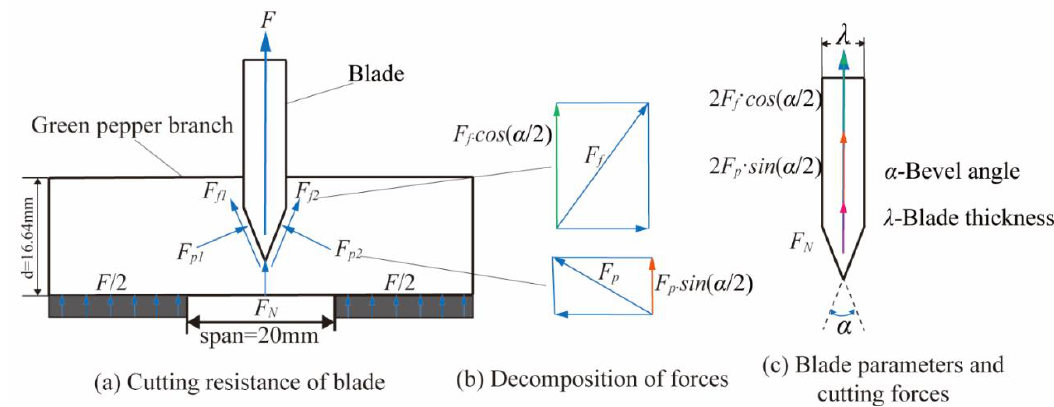
Figure 6. Tool cutting theory analysis.